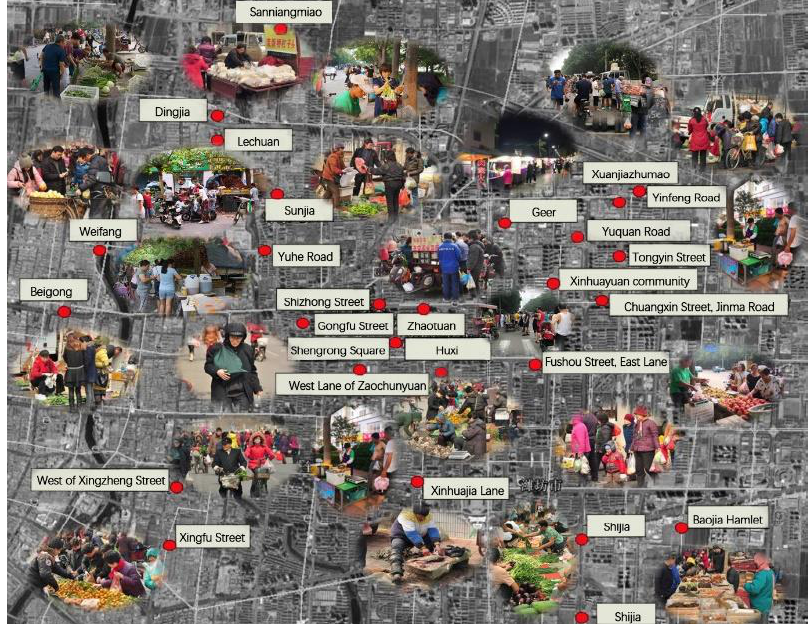
Figure 4. The traditional fairs in the main urban area of Wei fang city s distribution map (Source: Own drawing; Data source: On-site investigation).